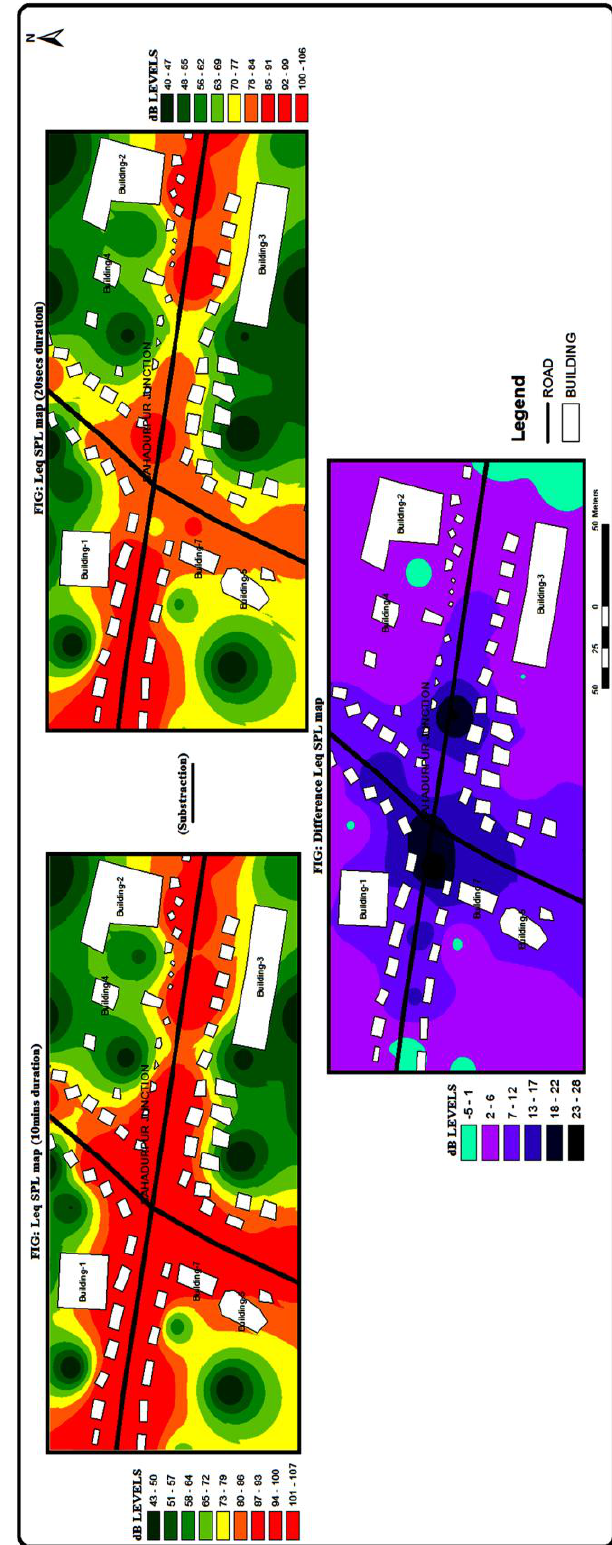
Figure 10. Average Noise Maps in Bahadurpur Crossing for Instantaneous and Short Time Duration and their Difference at 1-2 PM